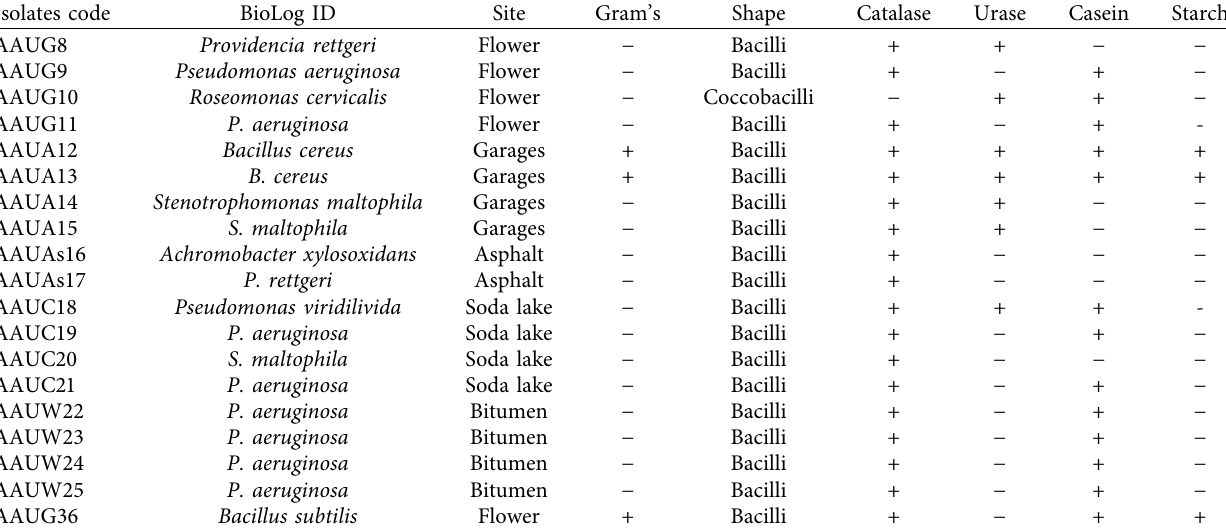
Table 1: Morphological and physiological characteristics of diesel-degrading bacteria isolated from different sampling sites.